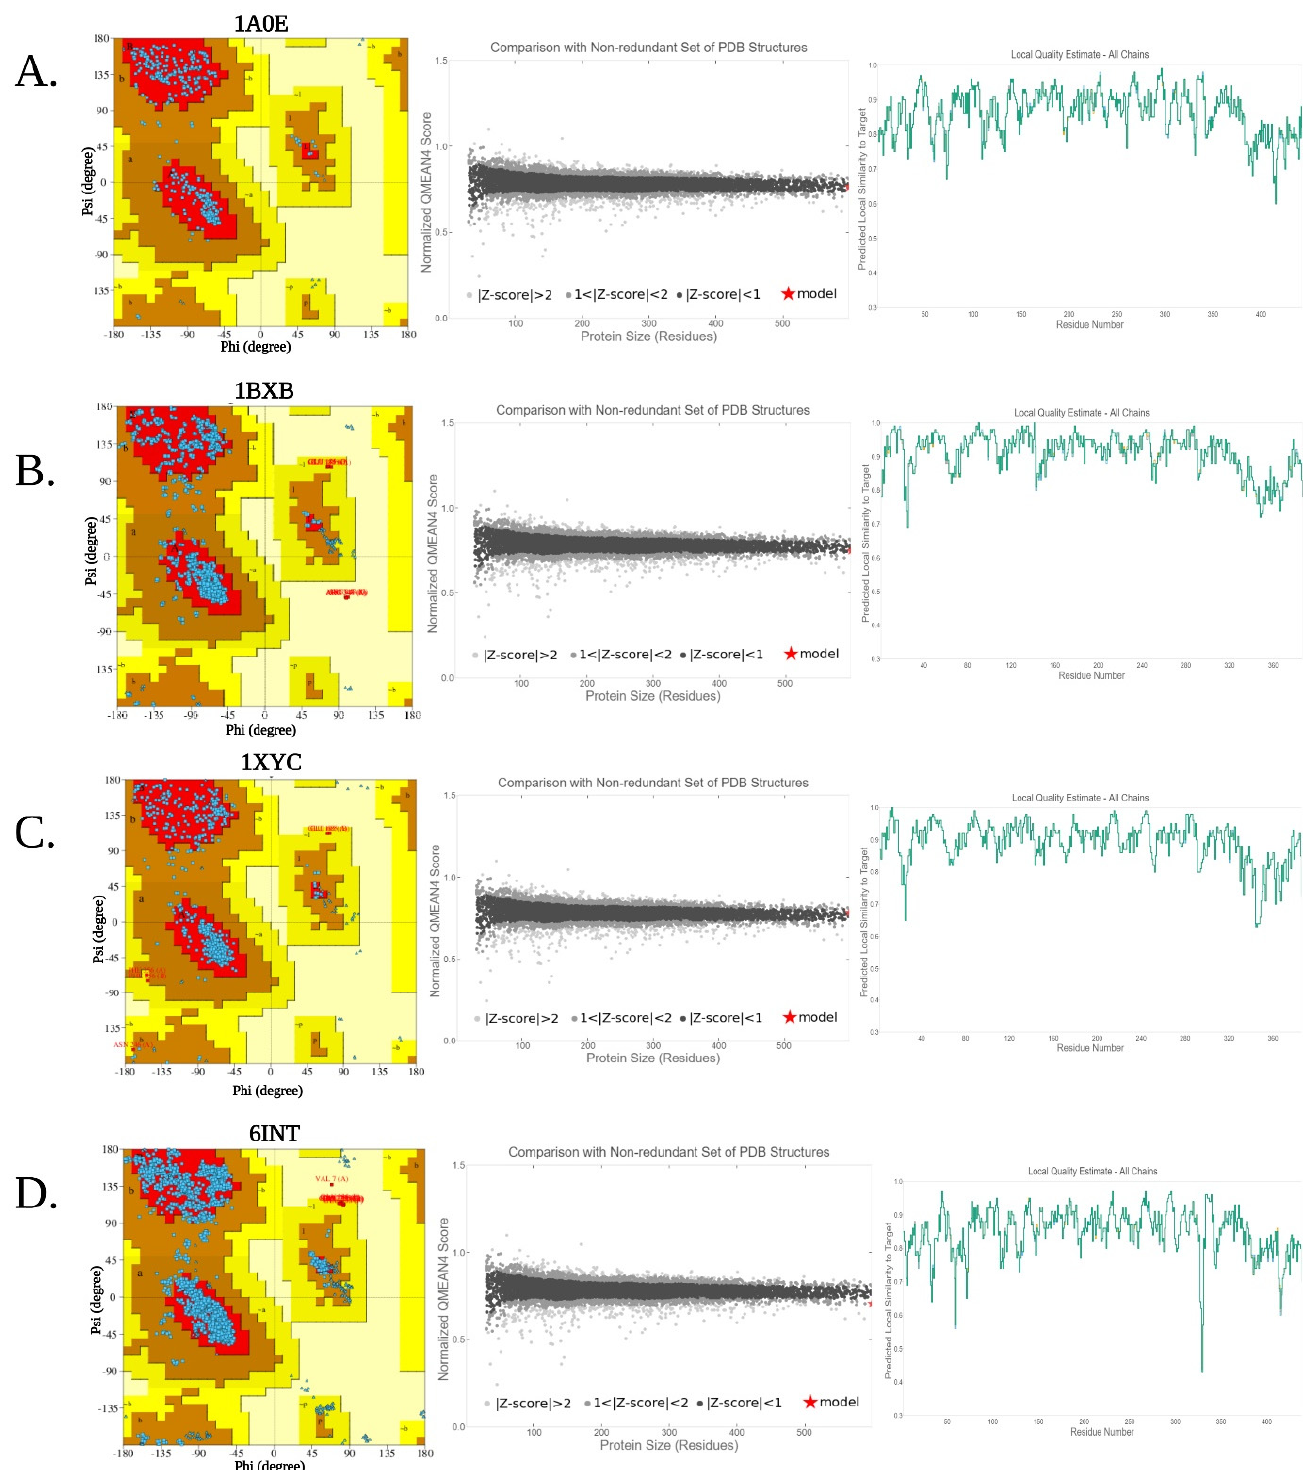
Figure 2. Quality assessment from Ramachandran plot, evaluation of Z-score, and local model quality estimation of ( A ) hyperthermophile, ( B ) thermophile, ( C ) mesophile, and ( D )